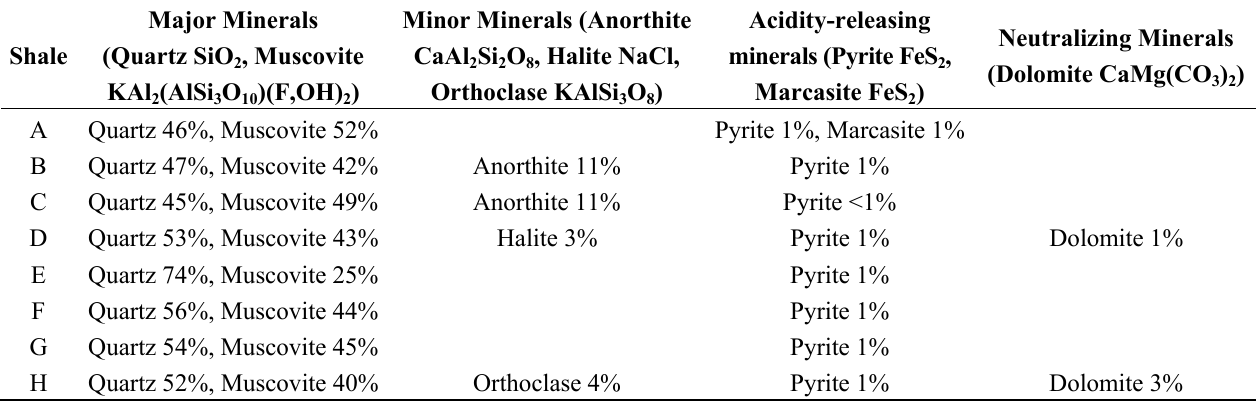
Table 2. Quantitative mineralogy (wt % abundance) from the shale samples using X-ray diffractometry. Blank cells indicate non-detection.